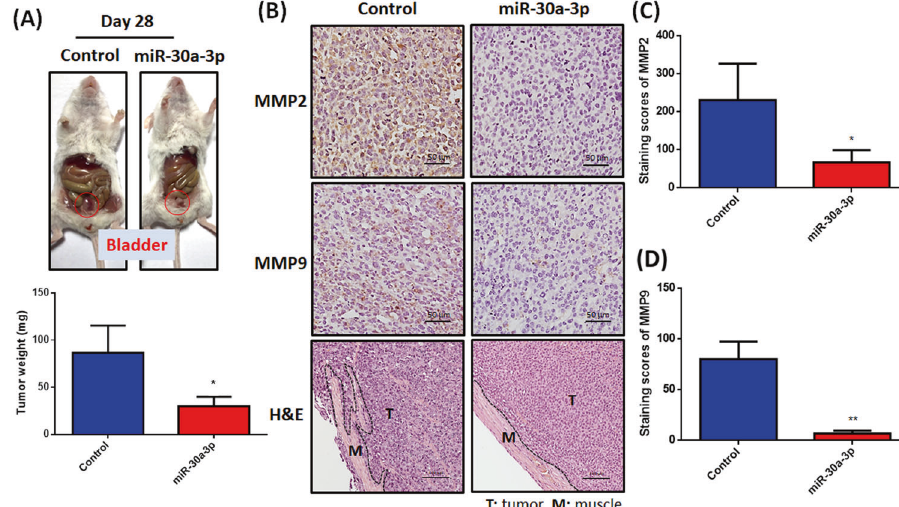
Fig. 4 Hsa-miR-30a-3p prevents tumor growth and muscle invasion in tumor-xenograft mice model. ( A ) UMUC3 cells were intravesically injected into SCID mice. Starting 1 week after tumor stabilization, the mice received twice-weekly lenti-miR-30a-3p plasmid. After 28 days, the tumor weights were recorded manually and quanti fi ed (N = 3). ( B – D ) IHC staining revealed MMP2 (N = 3) and MMP9 (N = 3) expression in murine tumor tissues. H&E staining was used to perform muscle invasion areas (T: tumor and M: muscle) (N = 3). All data are expressed as means ± SDs in triplicate samples. * P < 0.05, ** P < 0.01, *** P < 0.001, and **** P < 0.0001 relative to the control BC (Fig. S1A, C, D). Such fi ndings indicate that hsa ‑ miR ‑ 30a expression varies according to genetic differences.